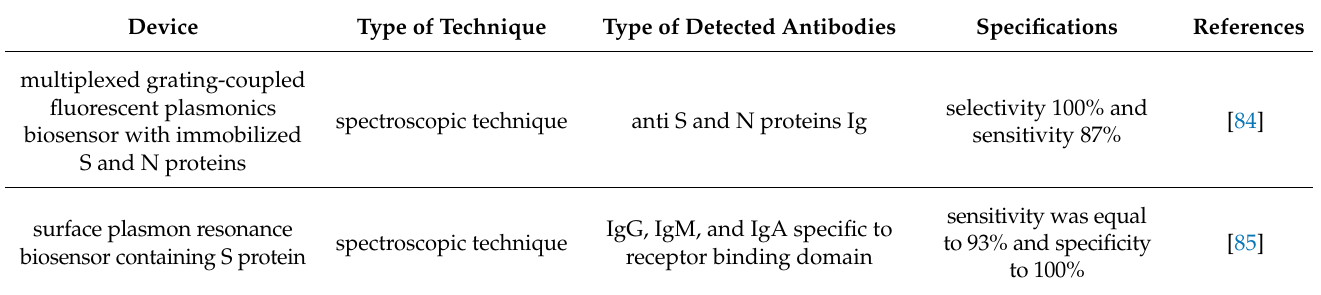
Table 1. Anti-COVID-19 point-of-care biosensors for measuring anti-SARS-CoV-2 antibodies.